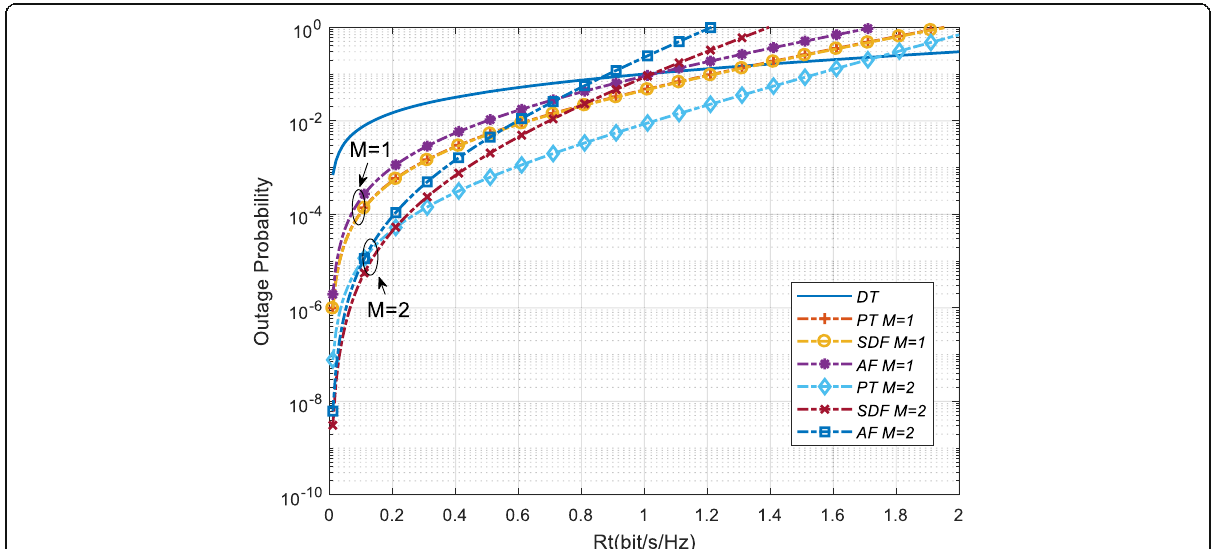
Fig. 6 Outage probability versus the information transmission rate. The figure shows that the simulations on outage probability versus transmission rate of partial transmission (PT) and three conventional cooperative strategies, direction transmission (DT), selective decode- and-forward (SDF), and amplify-and-decode (AF), on the situations with one-relaying system and two-relaying system. To simulate the unreliable relays, the simulation parameters are set as follows: the number of information bits is 100,000; the transmit SNR of source is 20 dB; and all the channel states from source to relays, relays to destination, and source to destination are set the same, as 0.1. It can be seen in Fig. 6 that the outage probability gets higher as the information transmission rate increases. For the case of two-relaying system at low transmission rate, the PT performs worse than SDF and AF. Because the relays at low rate have high probability to decode the message or help the decoding at destination, they are reliable relays, while the relays in PT cannot transmit all the information sequence. As transmission rate gets higher, the relays become unreliable, where the partial transmission shows the great advantage. However, if transmission rate rises to some certain threshold, all the relays are useless, so that the two-relaying system performs worse than the one- relaying system and even worse than the direct transmission. However, PT can postpone this